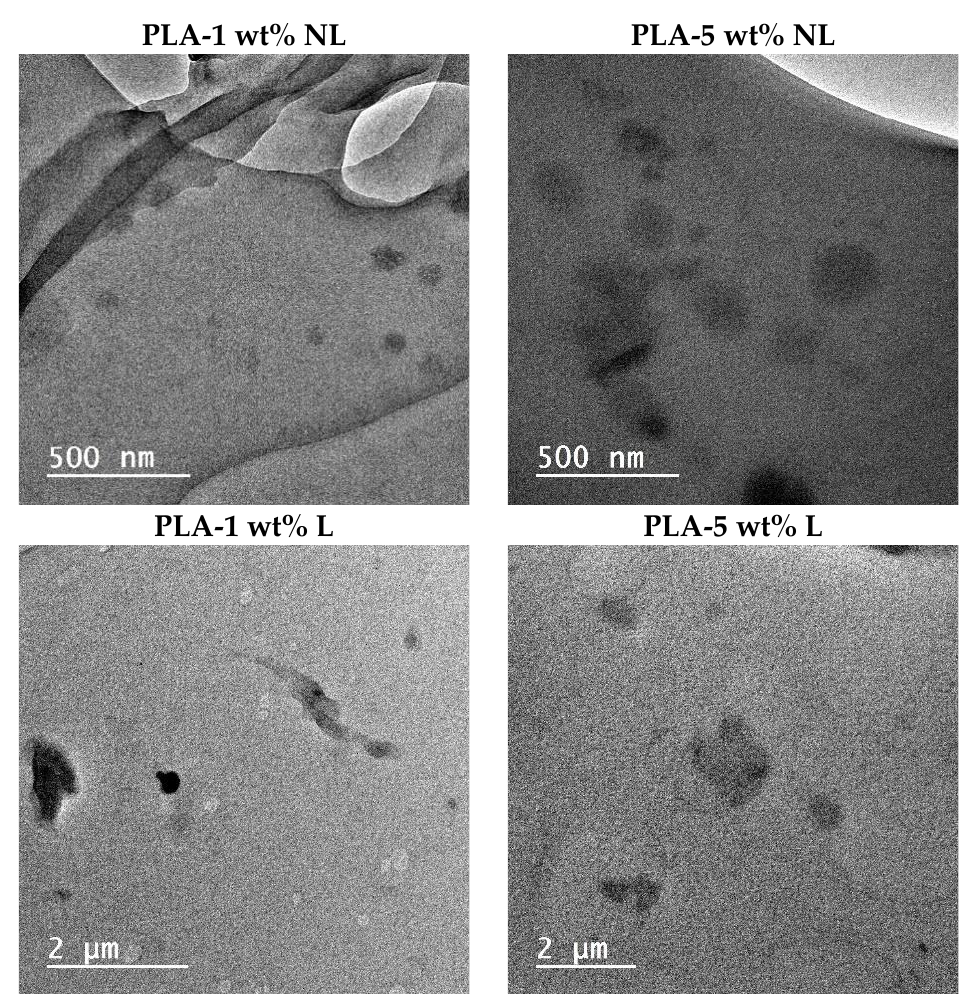
Figure 11. TEM micrographs of PLA–L/NL composites containing two different (1 and 5 wt%) filler contents.